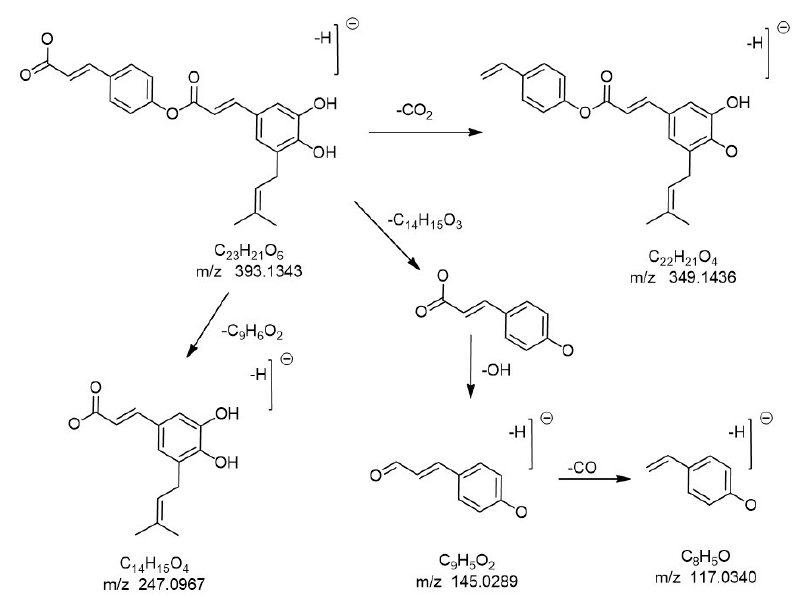
Figure 2. MS/MS spectra under low energy ( A ) and high energy ( B ) of 5 ‐ isoprenyl caffeic acid p ‐ coumaric acid ester.